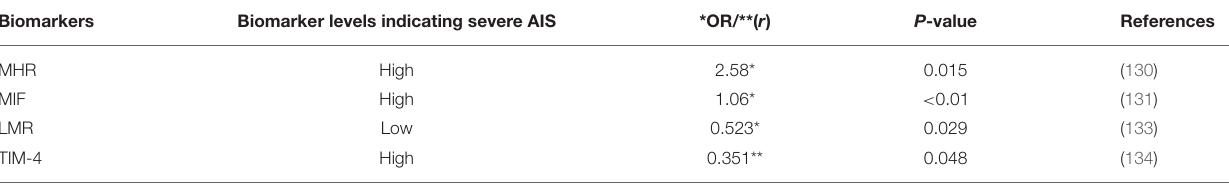
TABLE 2 | Monocyte-related biomarkers of acute ischemic stroke (AIS) outcomes.